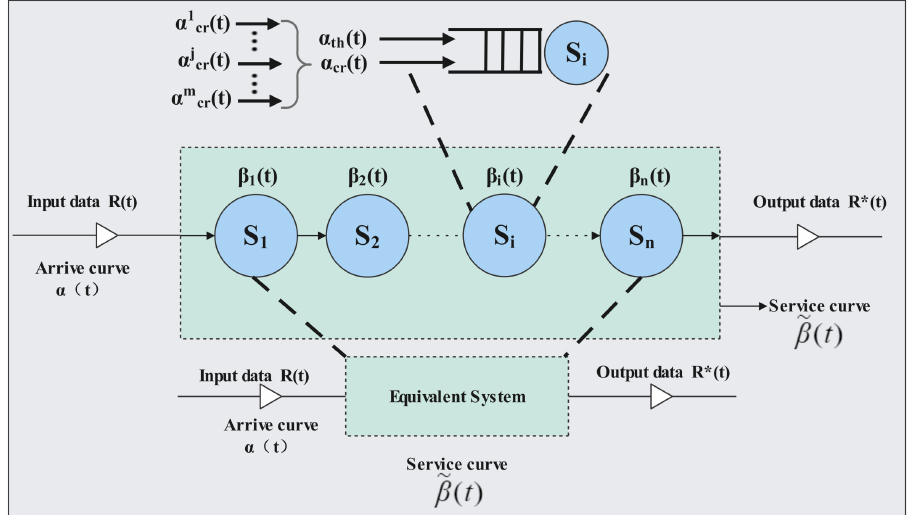
Figure 2. End-to-end Tactile Internet